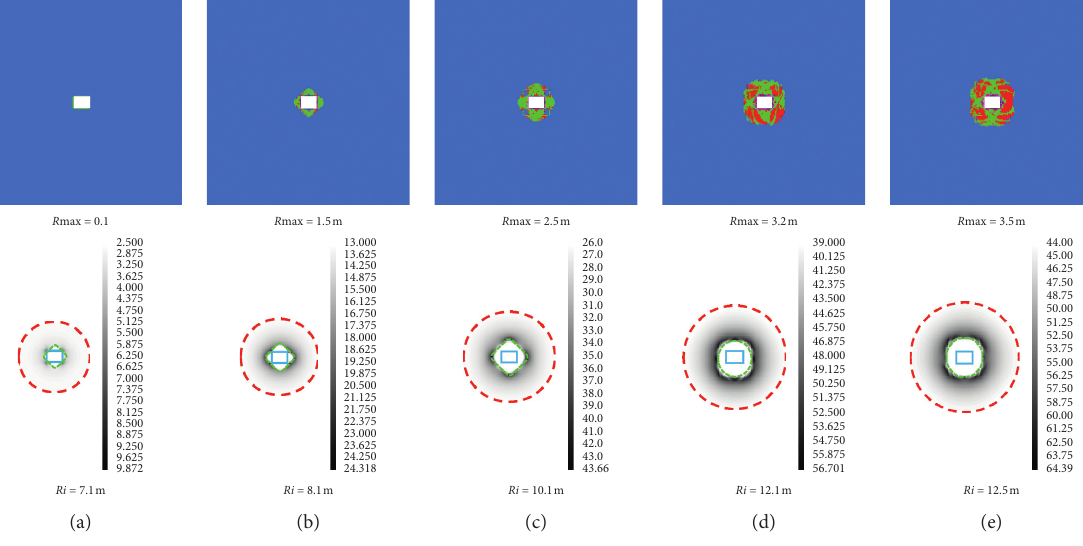
Figure 5: Plastic area of surrounding rock of rectangular fracture face and influence range of stress: (a) H � 100m; (b) H � 500 m; (c) H � 1000m; (d) H � 1500m; (e) H �